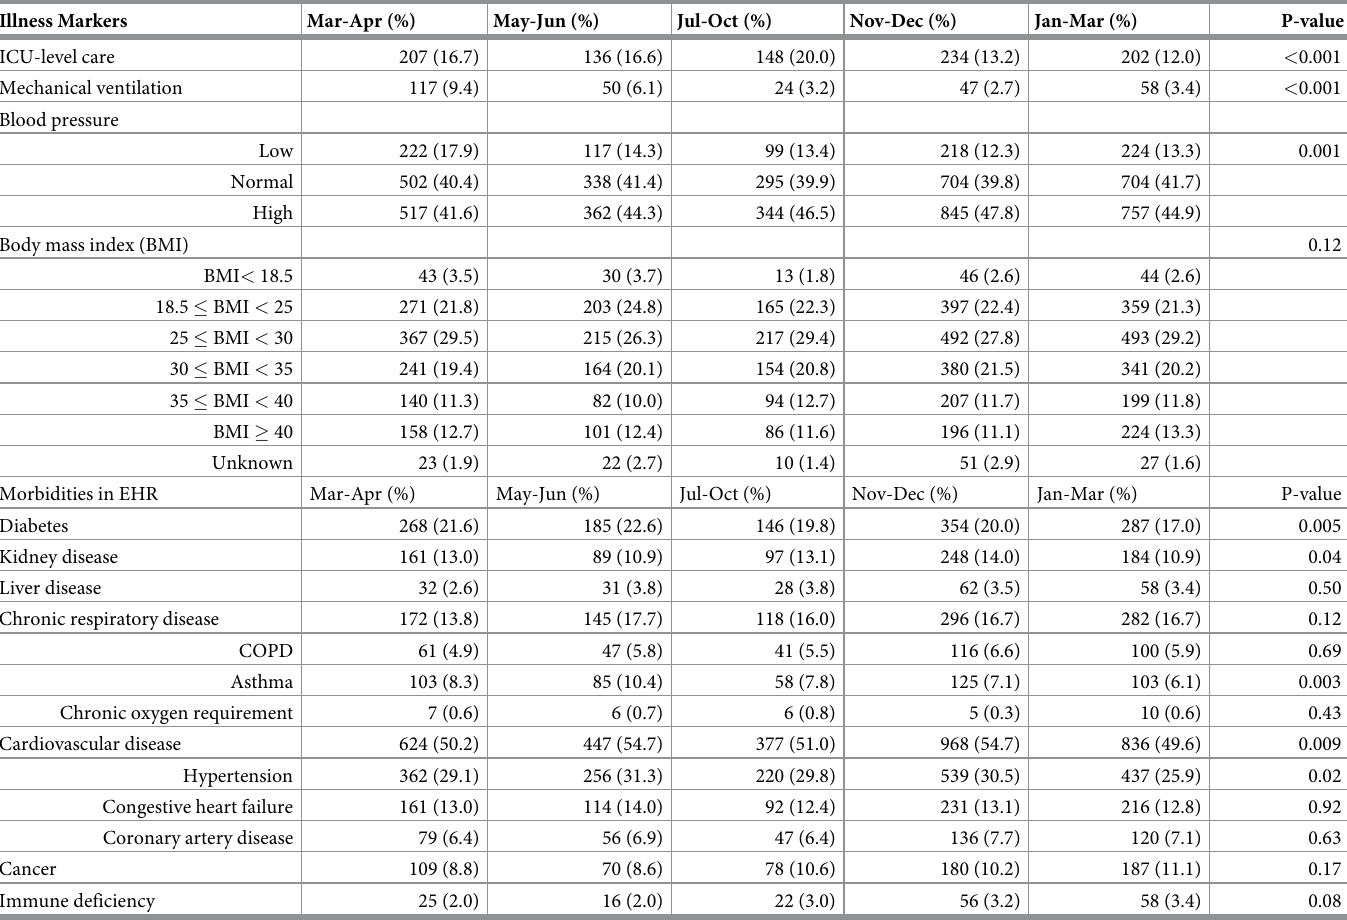
Table 2. Severity of illness markers and comorbid conditions based on ICD-10 Codes recorded within one year prior to the COVID-19 hospital admission. Illness Markers